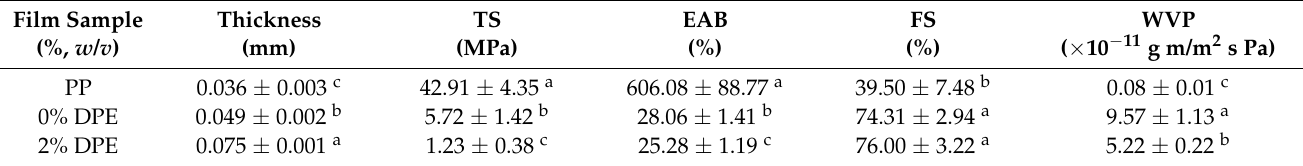
Table 1. Thickness, film solubility, mechanical, and barrier properties of polypropylene and DPE- enriched biocomposite